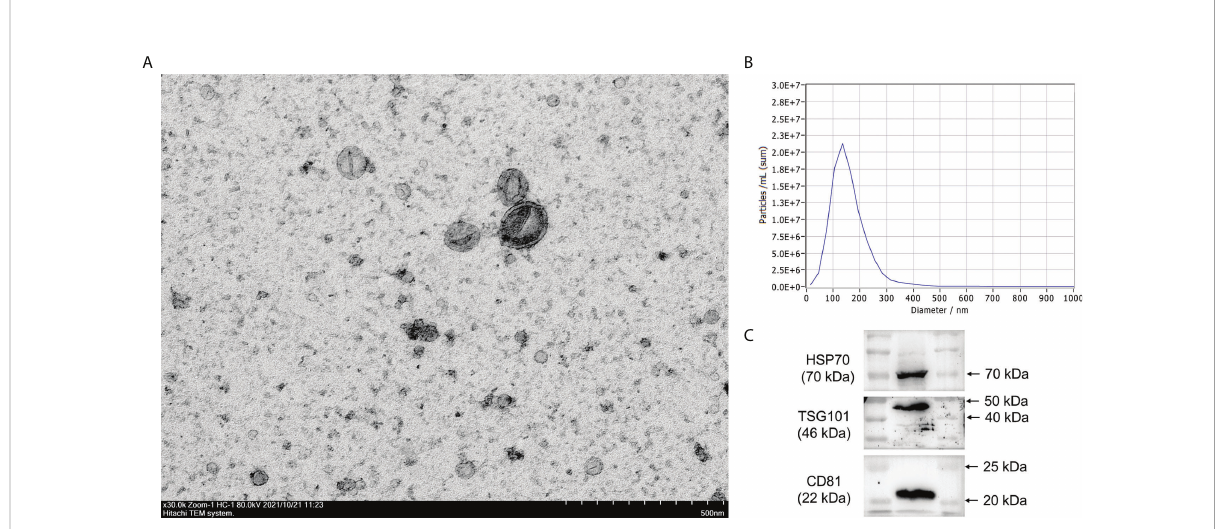
FIGURE 1 Characterization of exosomes. (A) Exosomes were extracted from human serum and morphological characterization was observed by transmission electron microscopy. (B) The size of exosomes was analyzed by nanoparticle tracking analysis (NTA). (C) Exosome protein markers HSP70, CD81, and TSG101 were identi fi ed by Western blot